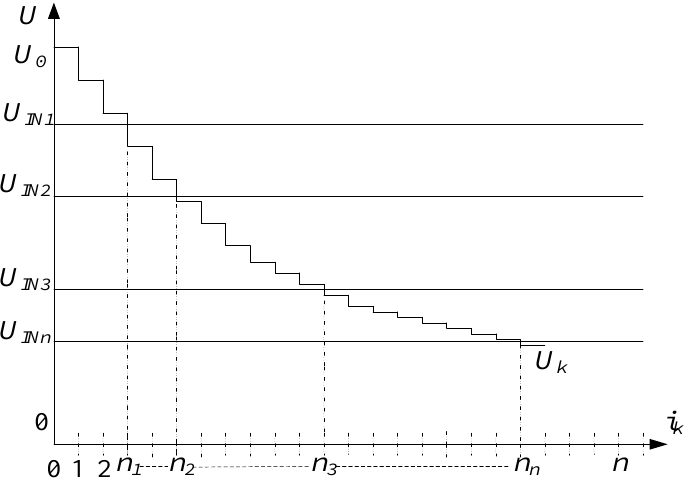
Figure 1. Voltage diagrams of a new method for functional analogue-to-digital conversion. During processing, the compensation voltage U k is varied by metered amounts starting from the reference voltage level U ref and compared with the input voltages U IN1 , U IN2 , . . . , U INn